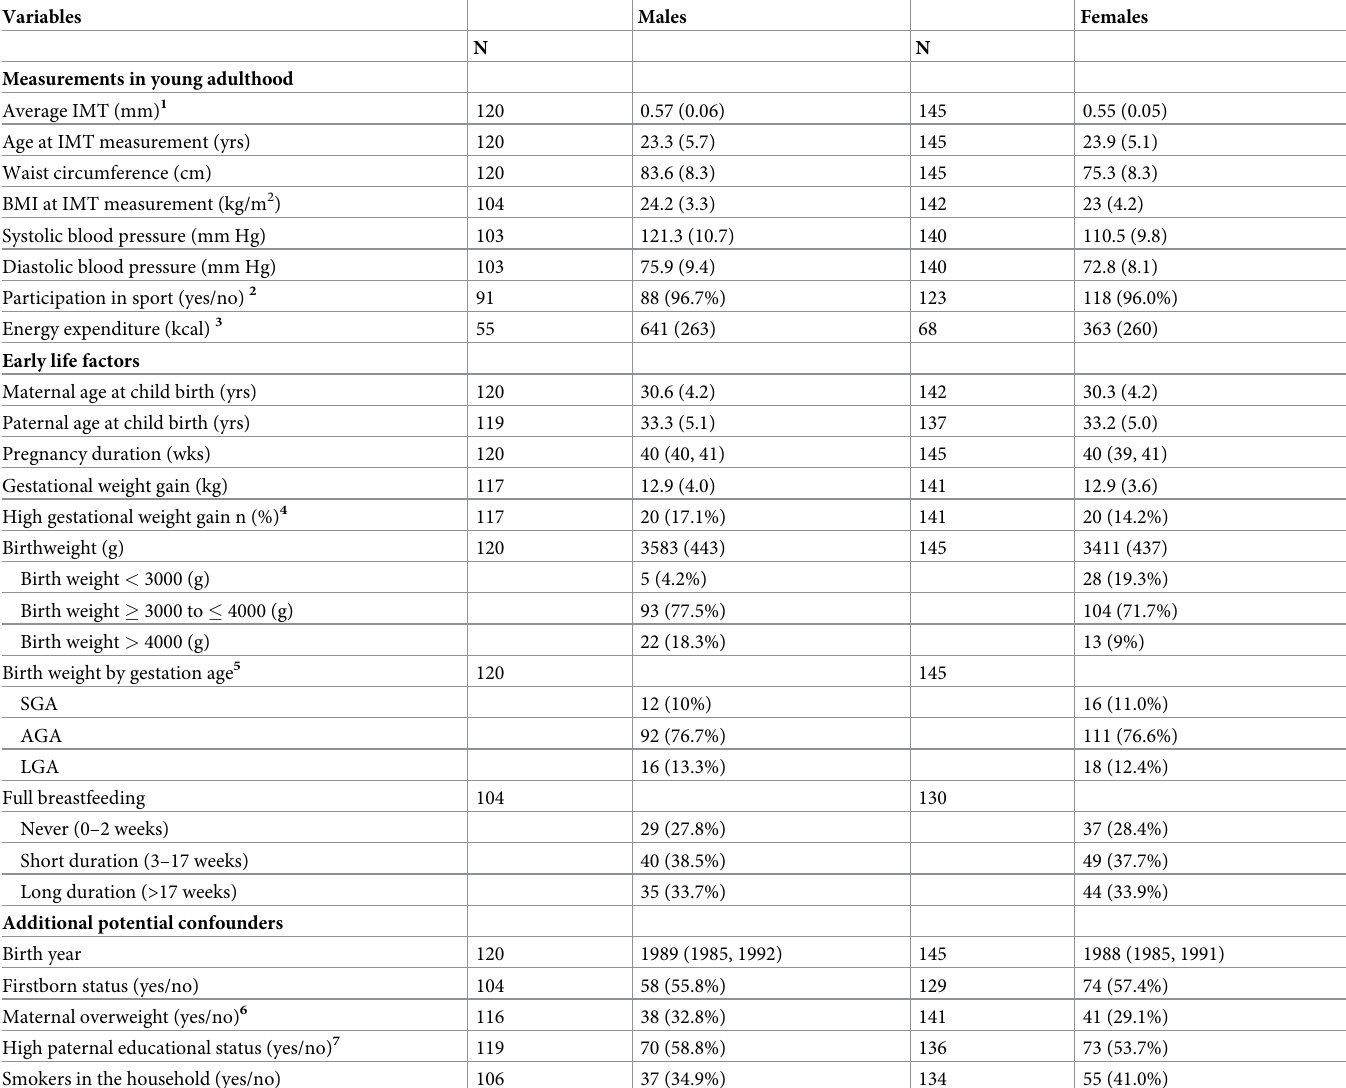
Table 1. Characteristics of participants in early life and young